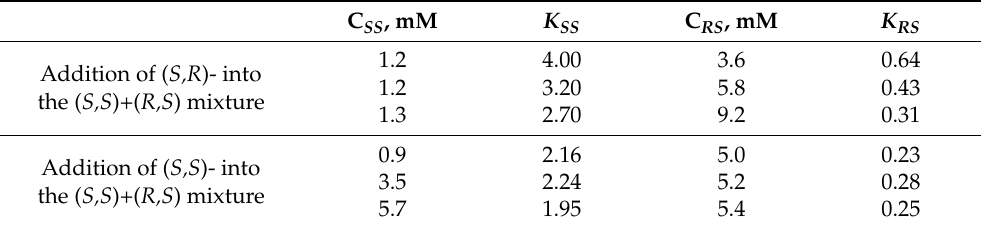
Table 6. Dependence of CIDNP coefficient ( K ) on the concentration of ( R,S )- and ( S,S )-diastereomers. The initial concentrations in the first experiment are 1.2 × 10 − 3 M of ( S,S ) and 3.6 × 10 − 3 M of ( R,S ), in the second—0.9 × 10 − 3 M of ( S,S ) and 5.0 × 10 − 3 M of ( R,S ). Subsequent additions of ( S,R )- or ( S,S )- are indicated as the sum of initial concentrations and the additive in the columns C SR and C SS . Optical density was varied from ca. 0.5 to 1.0. C SS , mM K SS C RS , mM K RS